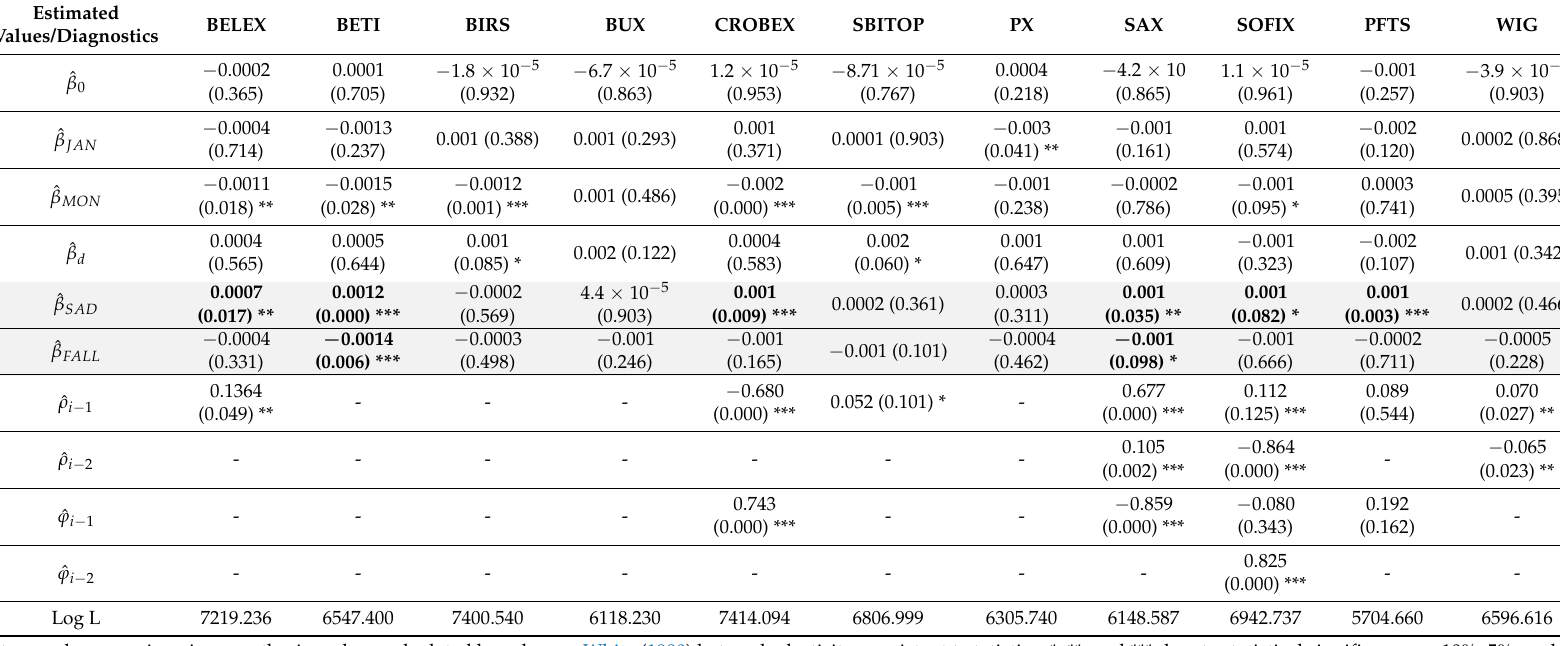
Table 2. Estimation results of Equation (6), bolded values indicate significant SAD and/or FALL